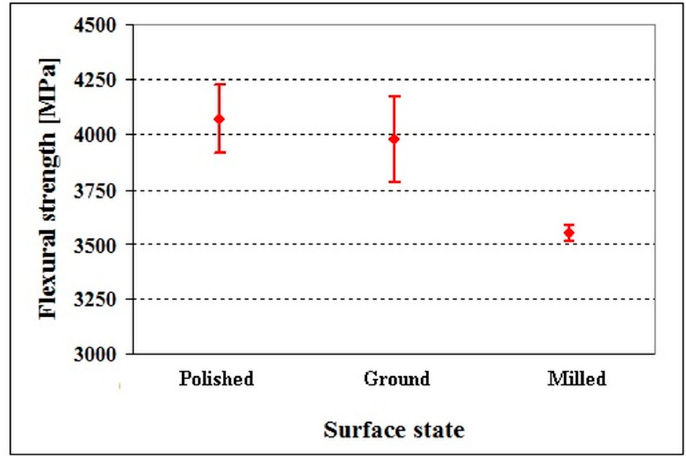
Figure 5. Flexural strengths of specimens made of the Vanadis 6 steel with different surface finish. Adapted from the corresponding literature [45]. (Copyright, Materials Engineering/Materiálové inžinierstvo, 2011).